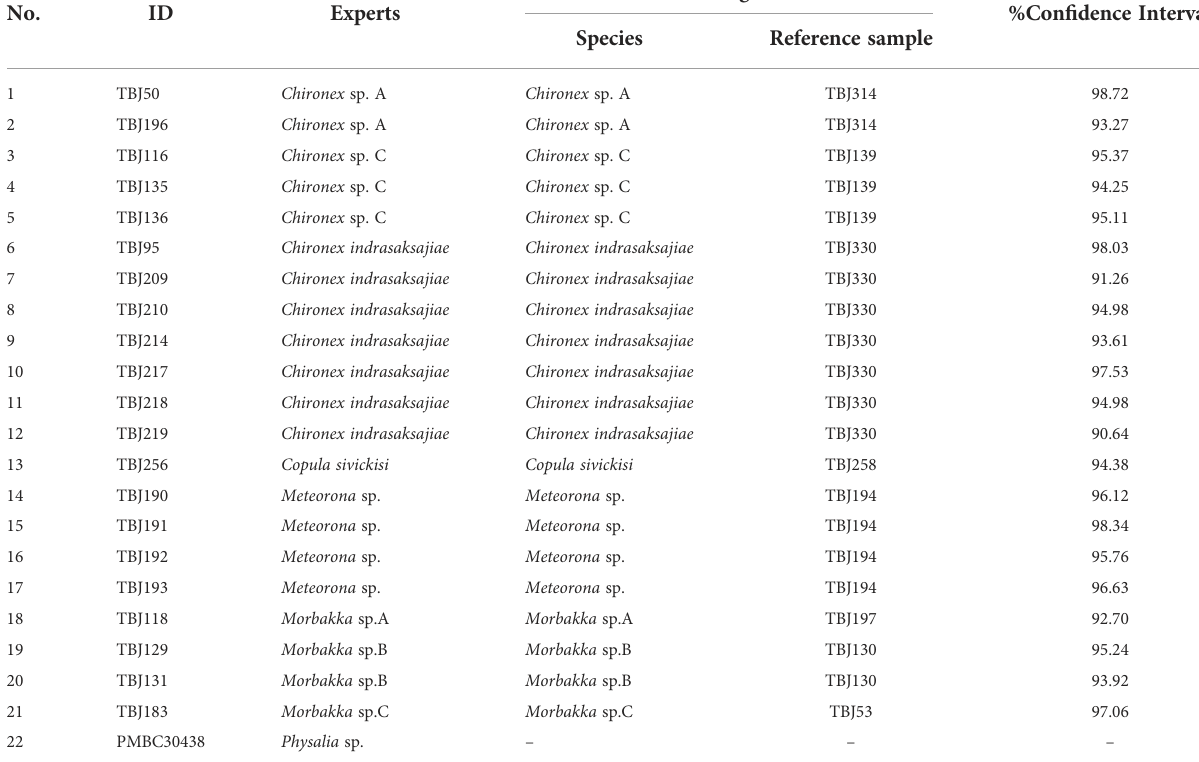
TABLE 5 Species determination via